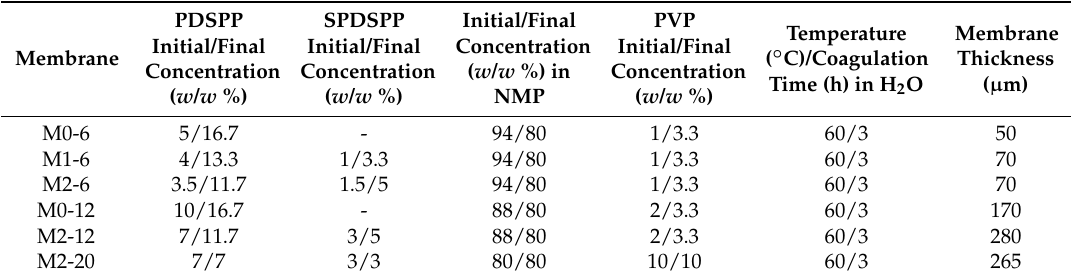
Table 6. Preparation of membranes with 80/20 w / w or 70/30 w / w PDSPP/SPDSPP in NMP at 5% and 15% w / w , addition of PVP at 3.3% w / w final concentration, casting at 80 ◦ C until 20% w / w total final polymers’ concentration and immersion in H 2 O at 60 ◦ C for 3